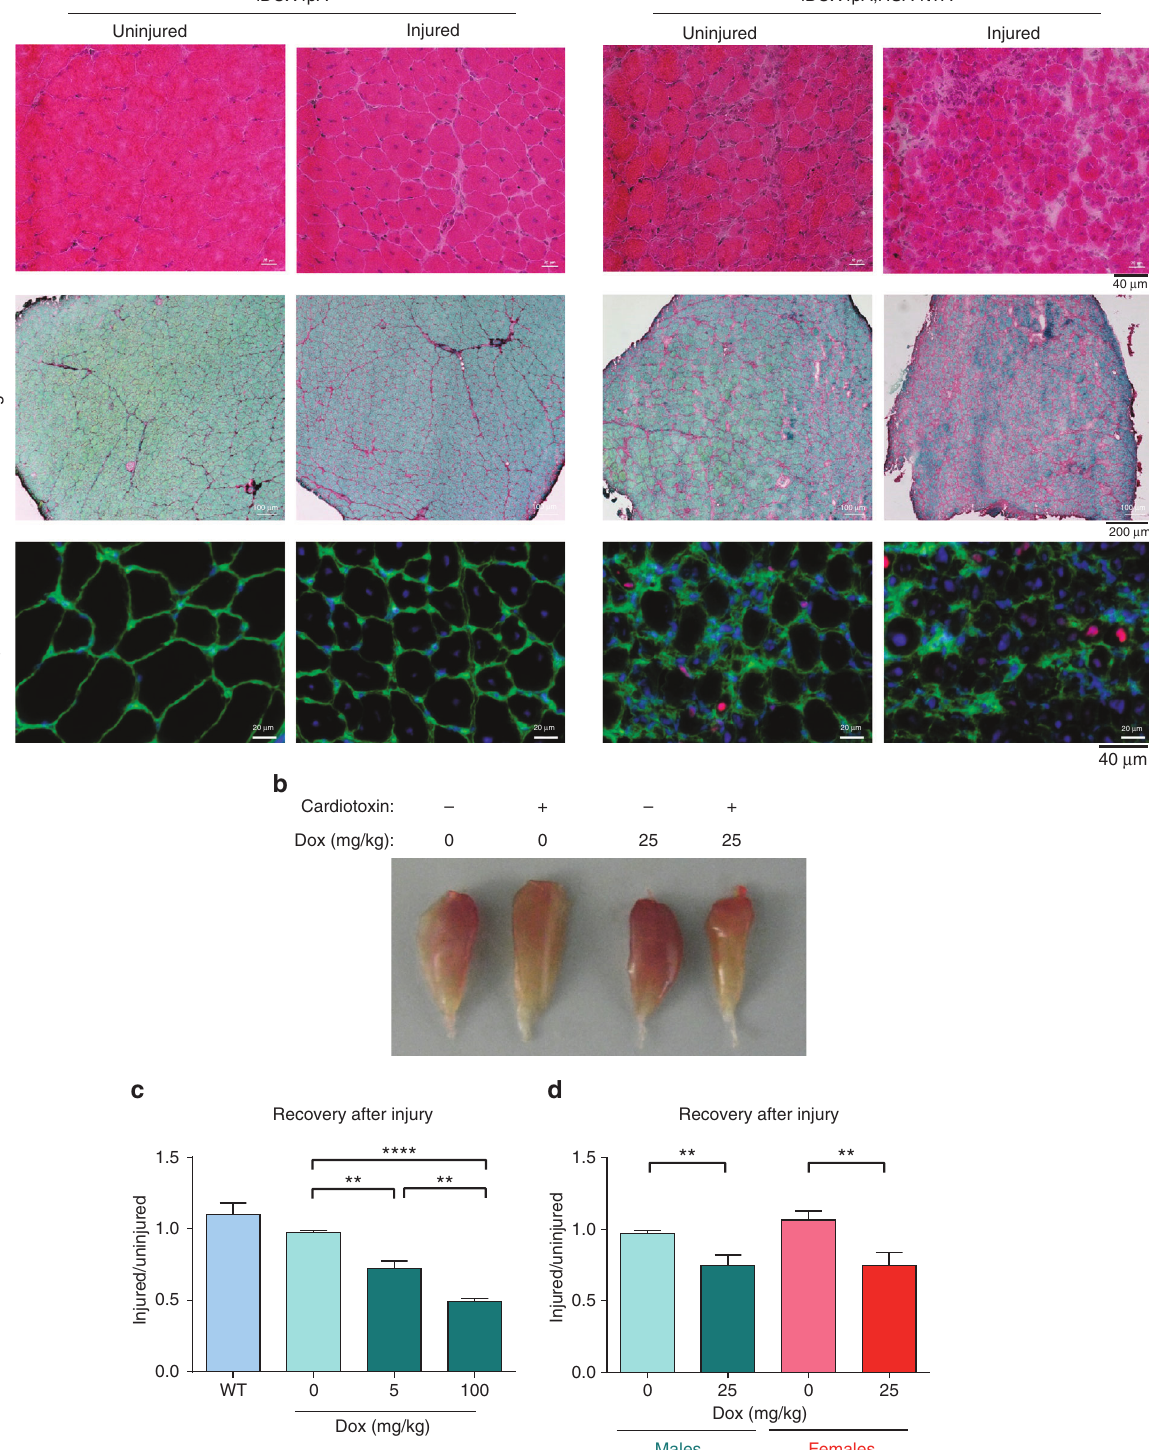
Fig. 4 DUX4 impairs recovery after injury. a Hematoxylin and eosin ( H&E ), Sirius red/fast green and immunostaining for DUX4, Laminin and DAPI nuclear staining of uninjured and injured TA muscle sections from iDUX4pA;HSA-rtTA males and controls lacking rtTA 12 days post injury. Mice were induced with 25 mg/kg doxycycline for 12 days. b Gross morphology of injured/uninjured TA muscles with/without DUX4 induction 12 days post injury. c Ratio of weight of post injury vs. uninjured contralateral TA from iDUX4pA;HSA-rtTA males, and siblings lacking rtTA or fully WT 12 days post injury ( n = 3). d Ratio of post injury vs. uninjured contralateral TA from iDUX4pA;HSA-rtTA male and female mice 12 days post injury. Mice were induced with 25 mg/kg doxycycline ( n = 3). Data are presented as mean ± SEM; ** p < 0.01, **** p < 0.0001 by c one-way ANOVA with Tukey ’ s post hoc test or d T